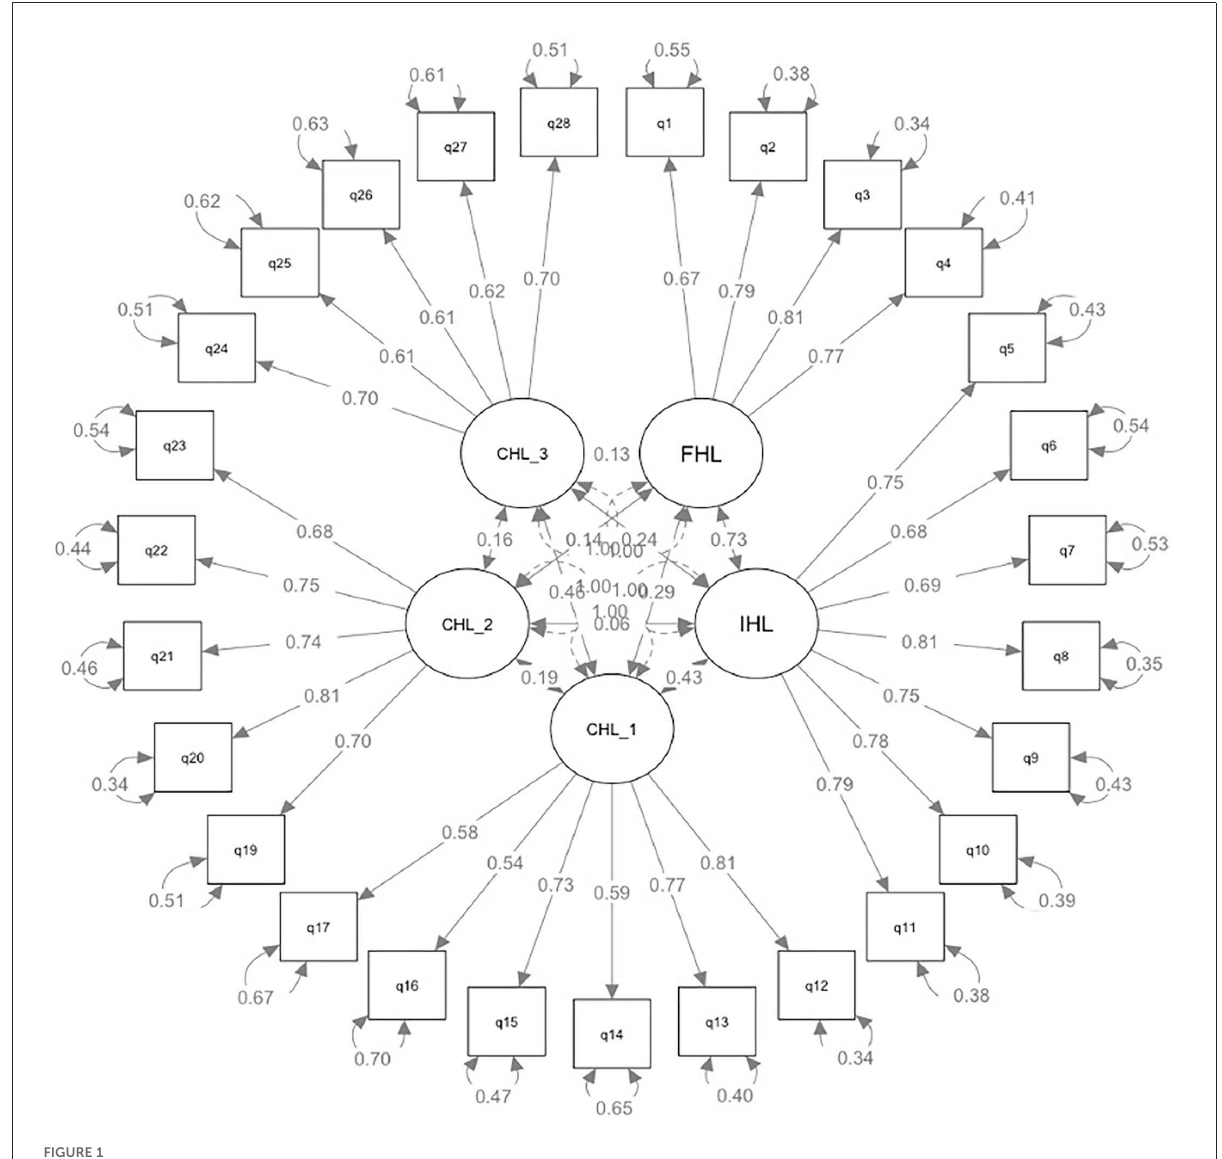
FIGURE1 Path diagrams of the CFA model (27